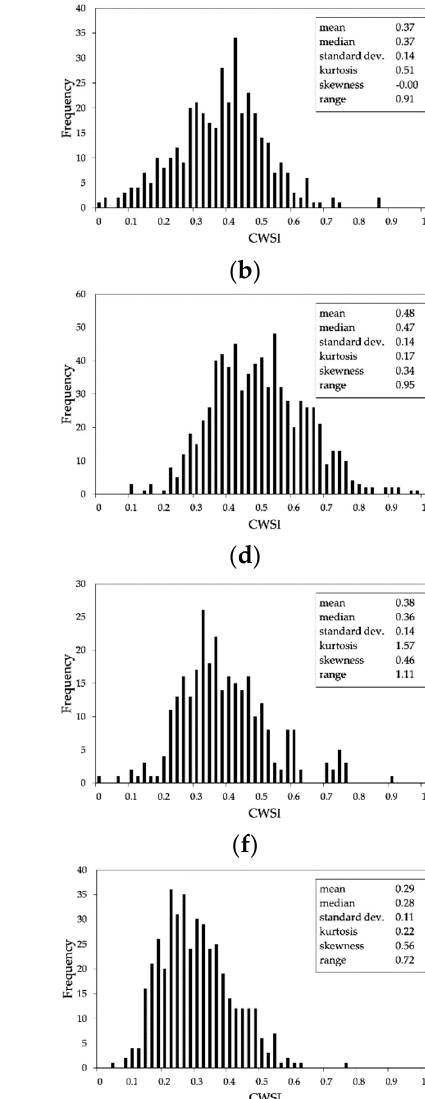
CA and correlation coefficients with the variables used to delineate SSMZ.